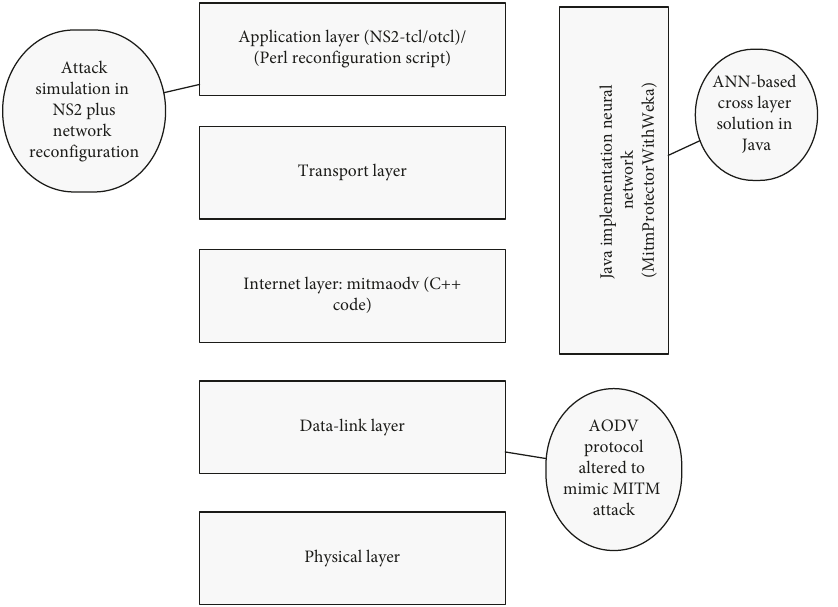
Figure 2: Conceptualization and design.